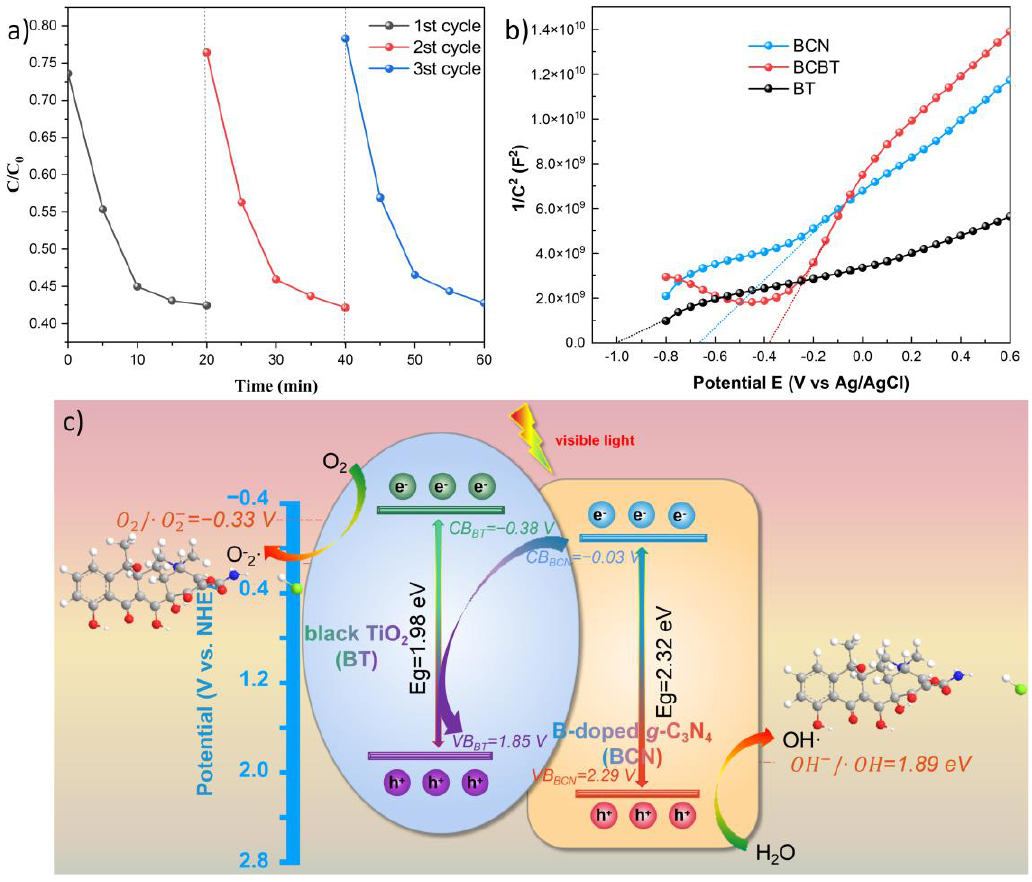
Figure 6. Recycling experiments ( a ), Mott – Schottky plots ( b ) of BCBT, and the presented mechanism ( c ) for photocatalytic TC elimination by BCBT photocatalyst.